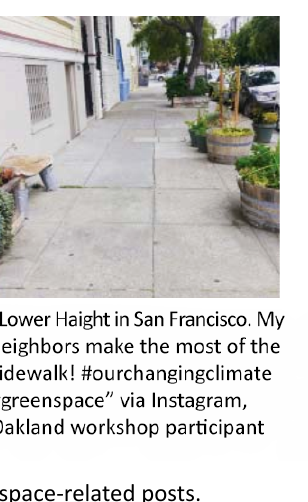
Figure 6. Transportation-related posts.